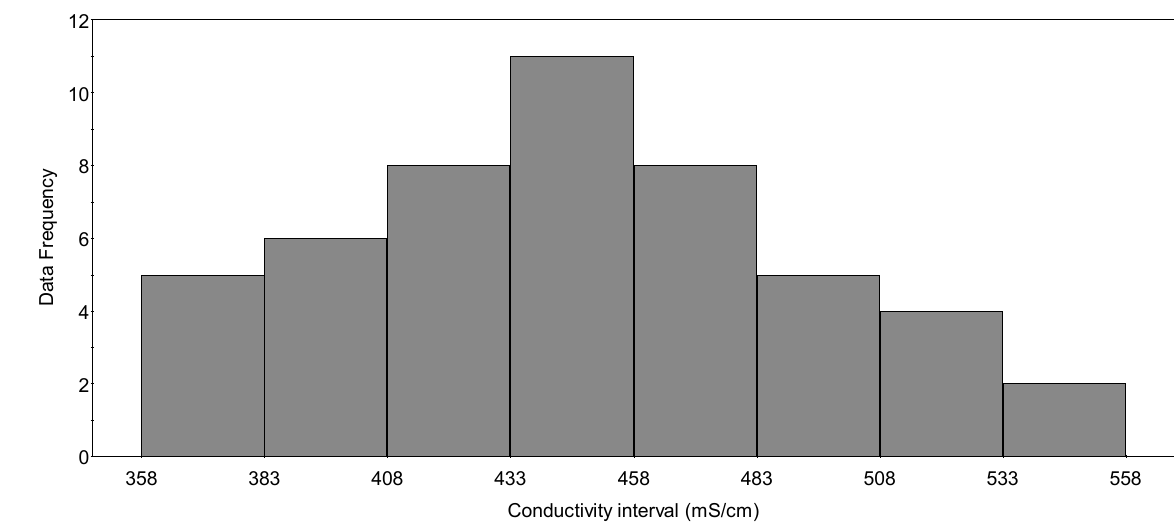
Figure 2. Histogram of the specific conductivity measured from the synthetic zinc electrowinning solutions utilized in this study.